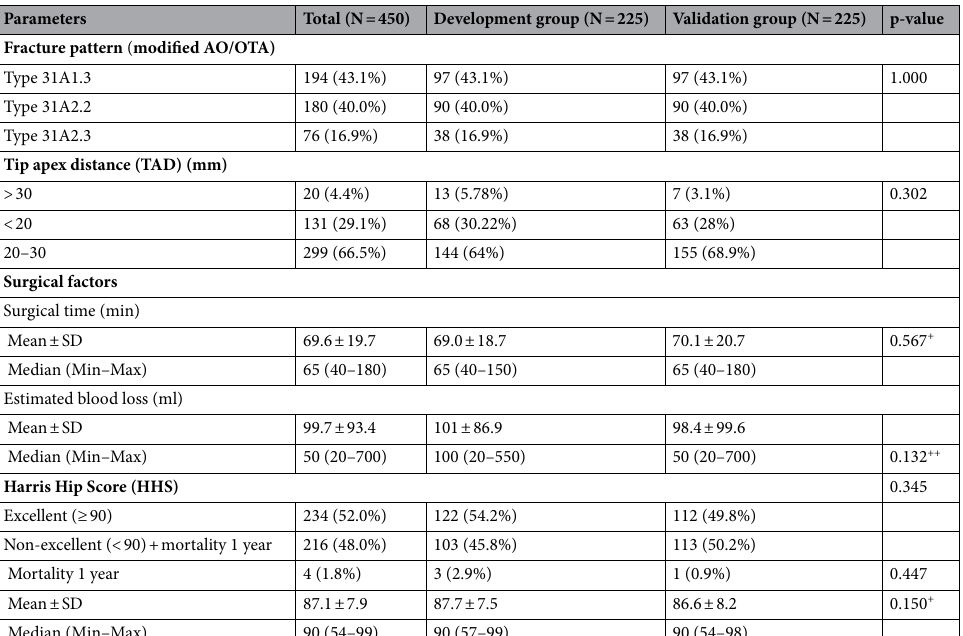
Table 2. Fracture pattern, surgical factors, and functional outcome (HHS at 1 year). Chi-square test; + Independent t test; ++ Mann–Whitney U test.